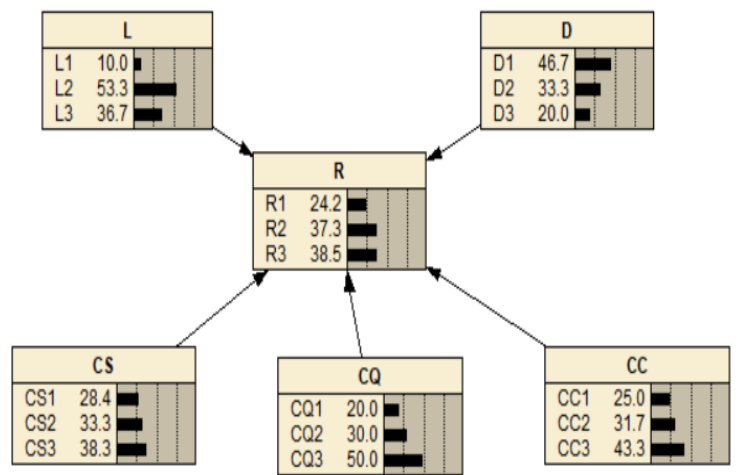
Figure 6. Risk status of ER2 displayed using Netica software.